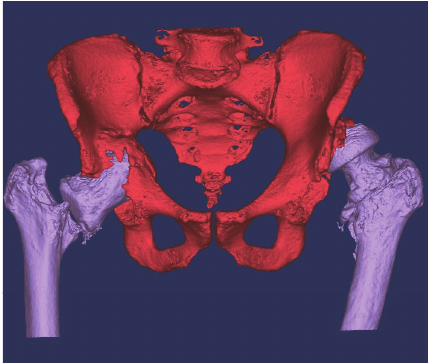
Figure 7: Thresholding and segmenting (deleting) the femoral bones from the pelvis.